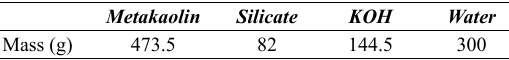
Table 5. Amounts of raw materials required to prepare 1 kg of the geopolymer.